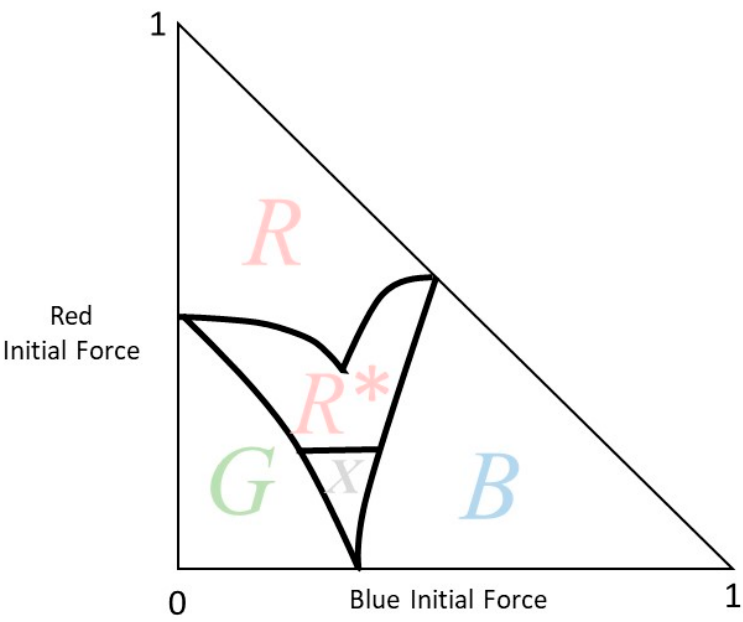
Figure 3. Unconditional winning regions, optimized winning region, and “victor maker” region for the case where the main battle is between Blue and Green .